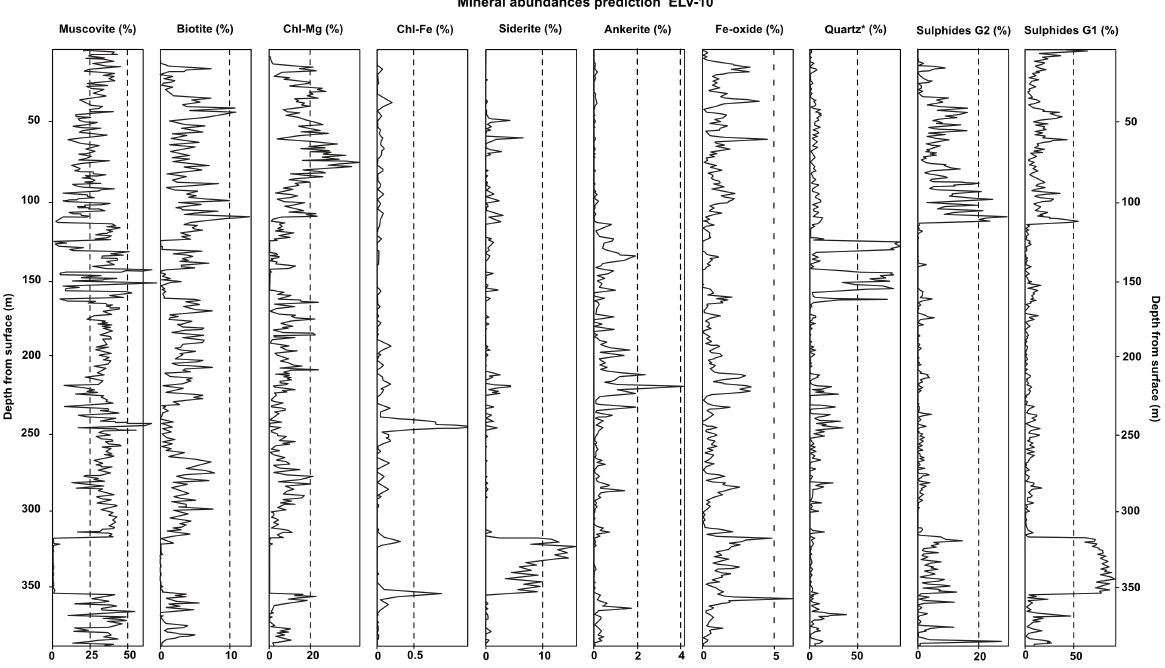
Figure 6. Multivariate dataset of mineral abundances prediction for Muscovite, Biotite, Magnesium- rich Chlorite, Iron-rich Chlorite, Siderite, Ankerite, Iron Oxide, Quartz, Sulfide group 1 and Sulfide group 2 along the borehole ELV-10. For details on methodology see